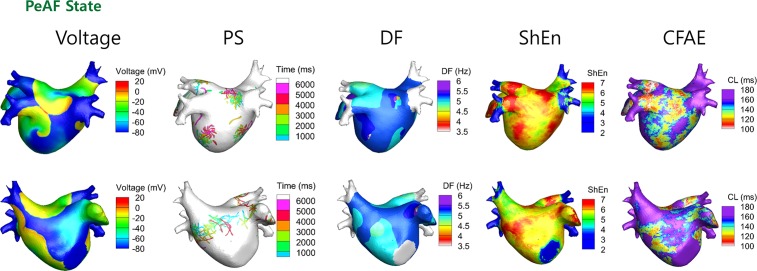
Three-dimensional maps of wave dynamics parameters.Maps of voltage, PS, DF, ShEn, and CFAE are shown for the case in which mother rotor was observed. The PS, DF, ShEn, and CFAE were mapped for 6 s.